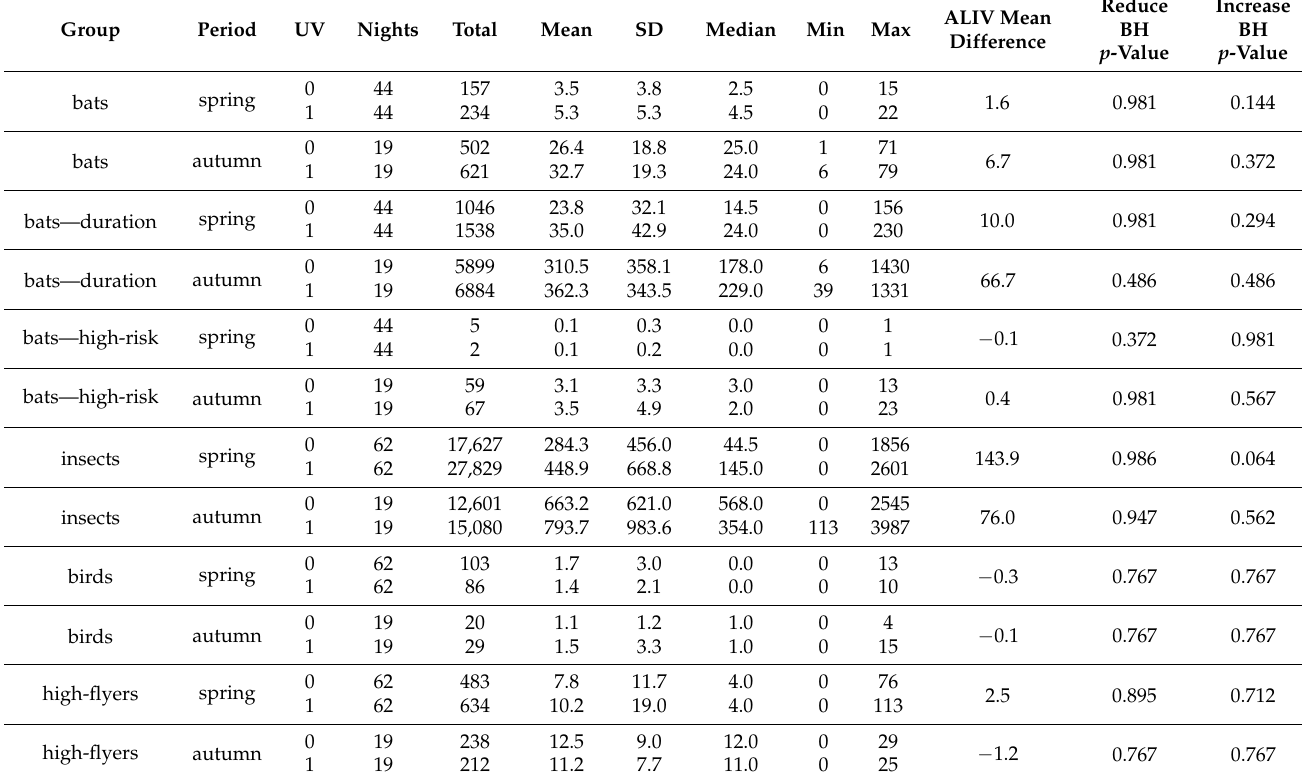
Table 1. Descriptive statistics of nightly detection counts for each group (“bats”, “insects”, “birds”, and “high-flyers”) by test period (“spring” and “autumn”) and control (UV = 0) and treatment (UV = 1) nights. The group “bats-duration” is the total nightly duration (seconds) during which bats were detected. The group “bats-high-risk” is the total nightly count of detections in which bat flight occurs within the rotor-swept zone. “Total” is the sum of detections for all control and treatment nights. Additional metrics include the mean difference between actual and linearly interpolated values (ALIV) of control and treatment, and p -values for each directional test of treatment effect (Reduce, Increase) as adjusted by the Benjamini–Hochberg (BH; [72]) procedure separately for each